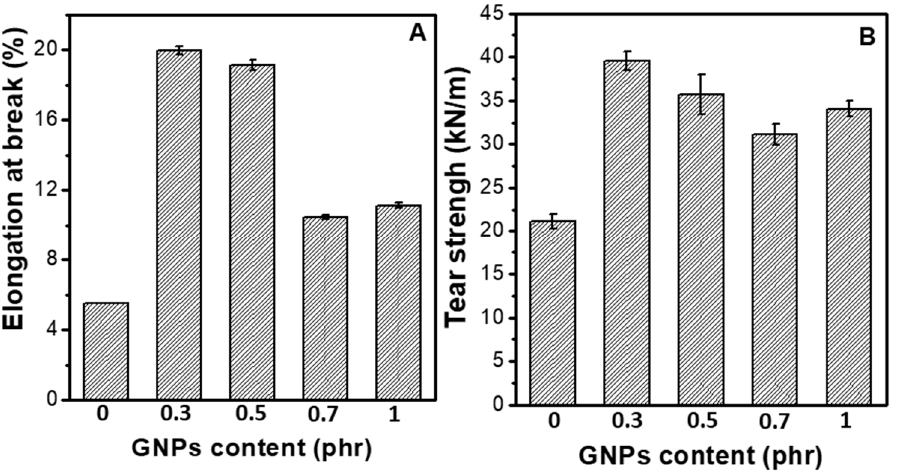
Figure 6. ( A ) Elongation at break and ( B ) tear strength of the control samples and the GNPs/natural rubber composites.